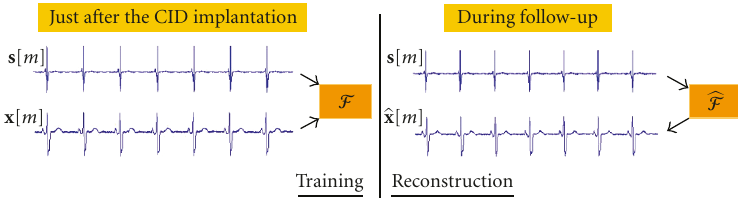
Figure 2: A two-step proposed procedure.